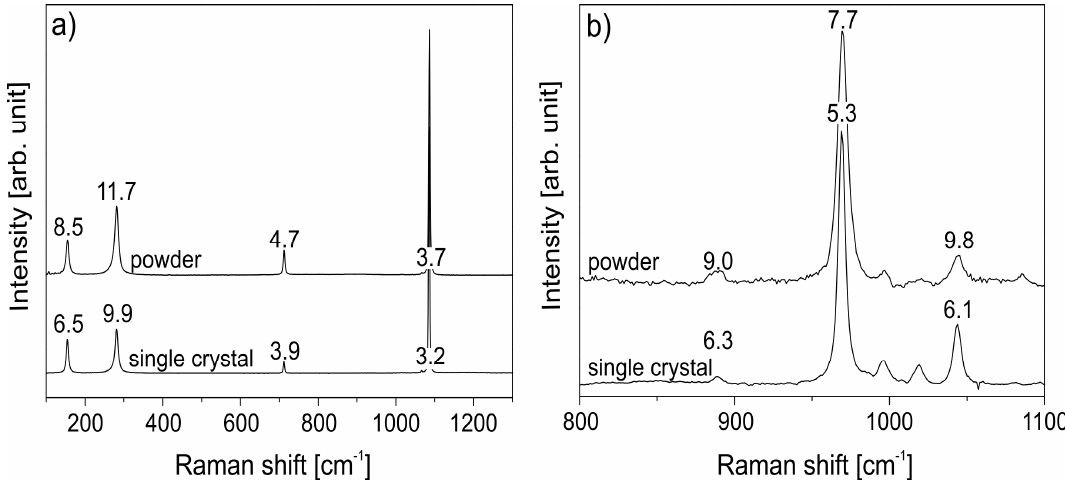
Figure 7. Comparison of Raman spectra from single crystals (E1A) and powders (E1B) of ( a ) calcite and ( b ) wollastonite. Numbers give the full width at half maximum (FWHM) of the respective band. Note that the Raman bands measured on powders are characterized by larger FWHM values.